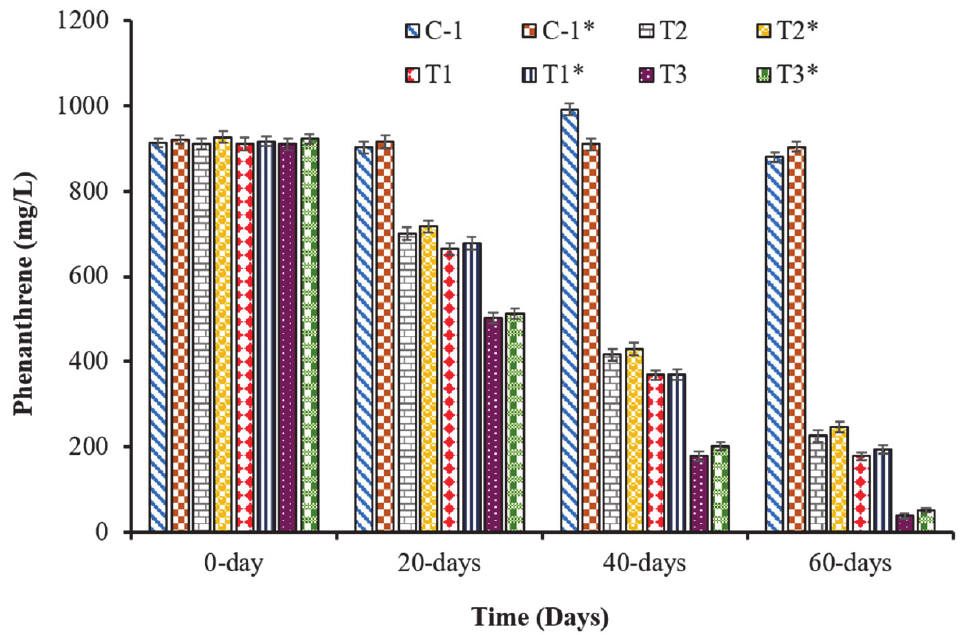
Figure 7. Phenanthrene reduction in CWs and FTWs vegetated with Phragmites australis.